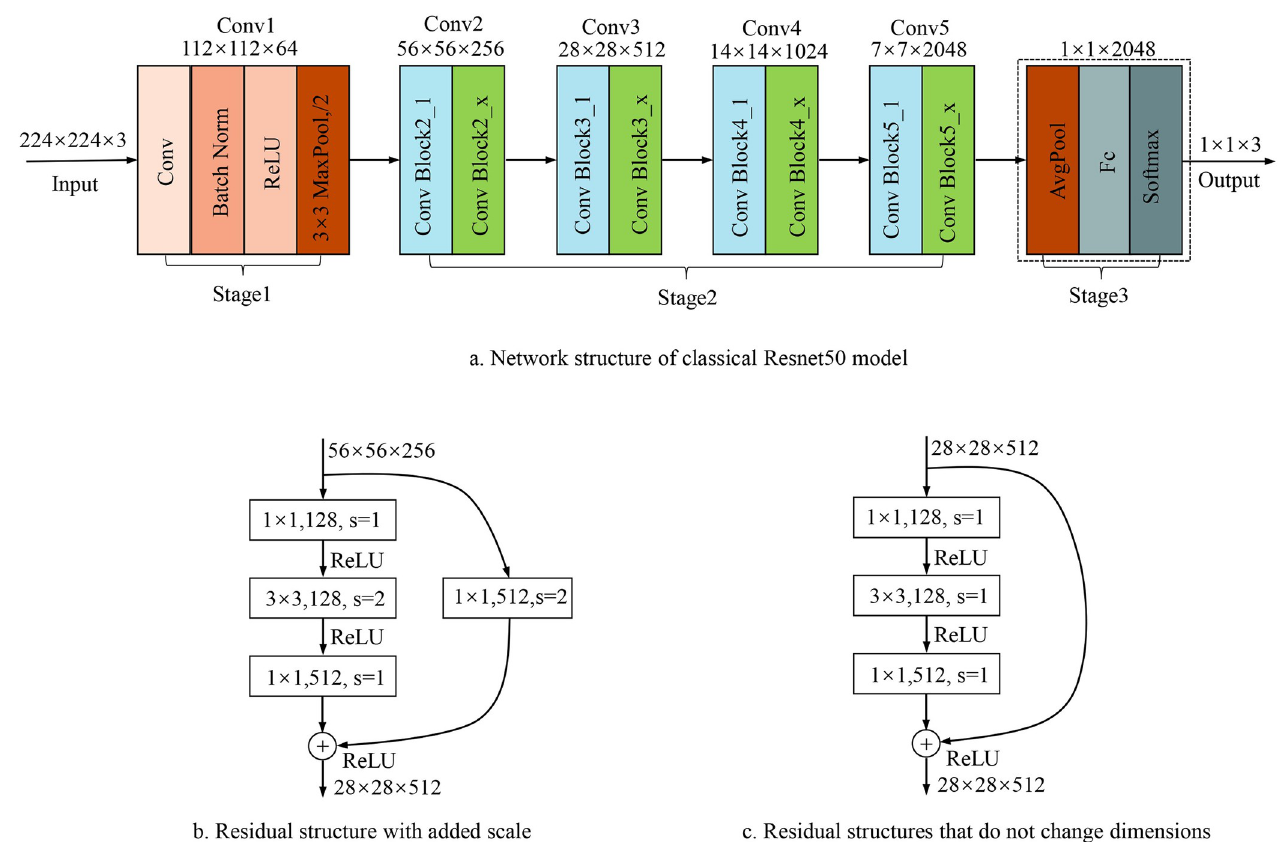
Fig 3. The network structure of the Resnet50 model. https://doi.org/10.1371/journal.pone.0273057.g003 the block with added scale, where the output feature matrix’s height and width were half of the input through shortcut branching. This operation contributed to preventing model degrada- tion. The residual structure 3c indicated that the feature size was unaltered, indicating that the output feature matrix’s height and width were also unaltered. 4.1.2. Convolutional block attention module model. The CBAM module is a highly effi- cient attention module that can be incorporated quickly and flexibly into conventional classifi- cation networks without adding a large number of parameters, thereby enhancing the representation of features in convolutional neural networks [33, 34]. Using the CBAM module, The ResNet50 model could extract the features of cotton seed image channels while retaining the property of accurate spatial location information. The structure of CBAM is shown in Fig 4. The Channel Attention Mechanism and Spatial Attention Mechanism made up the CBAM module. Given an input feature F , a channel compression operation was used to generate the channel attention weight M . Then, M was multiplied by F to obtain F 0 . The spatial attention C C weight M was then generated by a 2-dimensional spatial compression operation and multi- S plied by F 0 to produce F 00 . The specific calculation process is given in Eq 1.